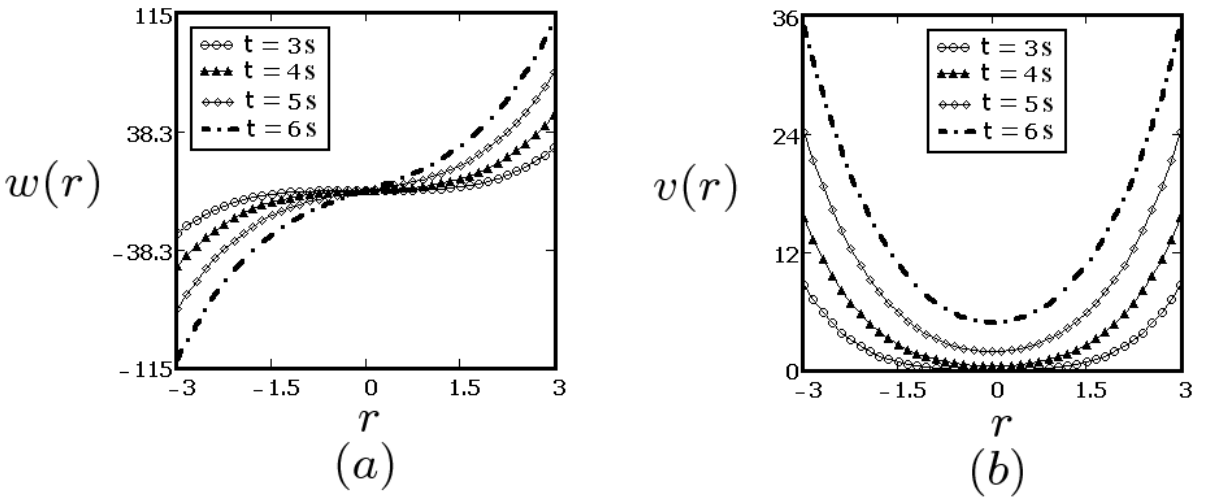
Fig. 2: Profiles of the velocity components w ( r , t ) and v ( r , t ) given by Eqs. (32) and (33), for R = 3, Ω = 1, U = 1, ν = 0.9292, µ = 26, λ = 3, α = 0.5, p = 2 and different values of t .